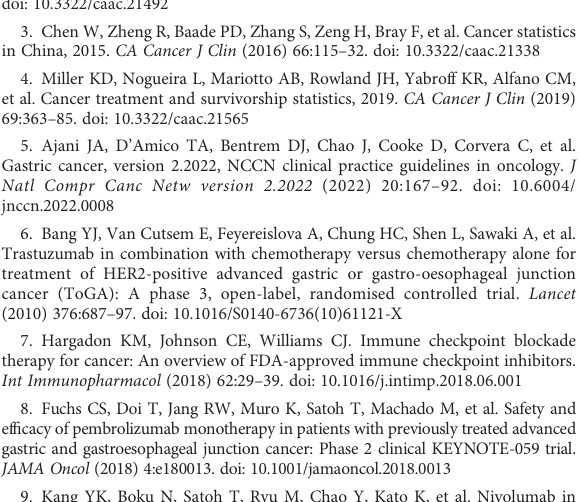
SUPPLEMENTARY FIGURE 1 Kaplan-Meier plot of overall survival in patients treated as fi rst and second-line therapy. SUPPLEMENTARY FIGURE 2 Kaplan-Meier plot of overall survival in patients treated as third-line or beyond therapy. SUPPLEMENTARY FIGURE 3 Kaplan-Meier plot of progression-free survival in patients treated as fi rst and second-line therapy. SUPPLEMENTARY FIGURE 4 Kaplan-Meier plot of progression-free survival in patients treated as third- line or beyond therapy. SUPPLEMENTARY TABLE 1 Univariate analysis and multivariate analysis for overall